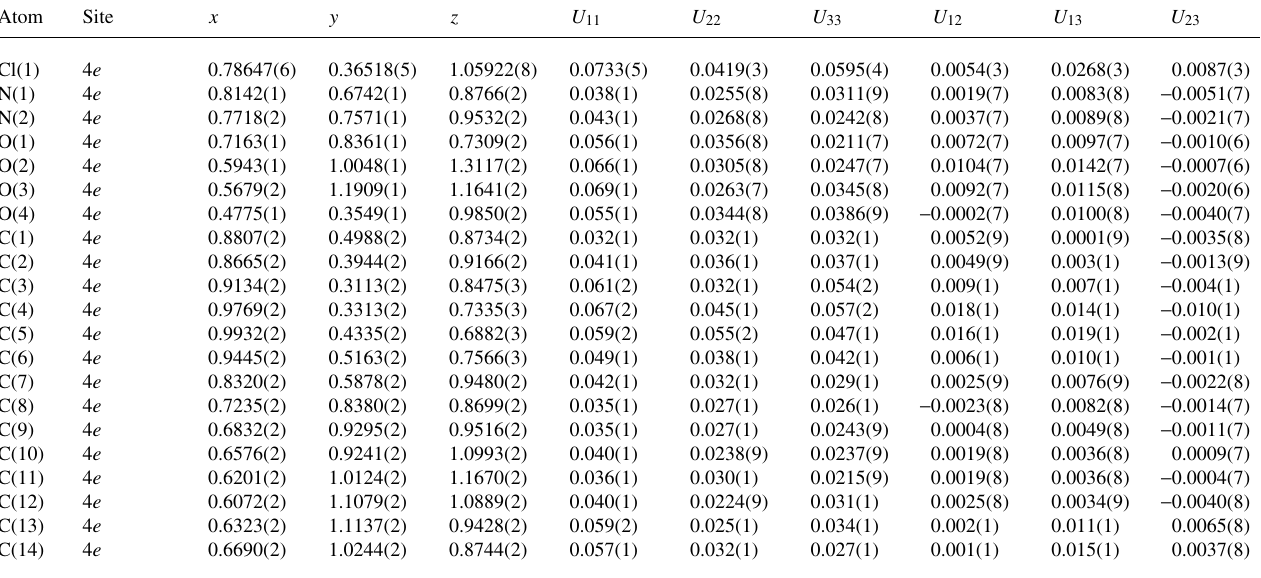
Table 3. Atomic coordinates and displacement parameters (in Å 2 )